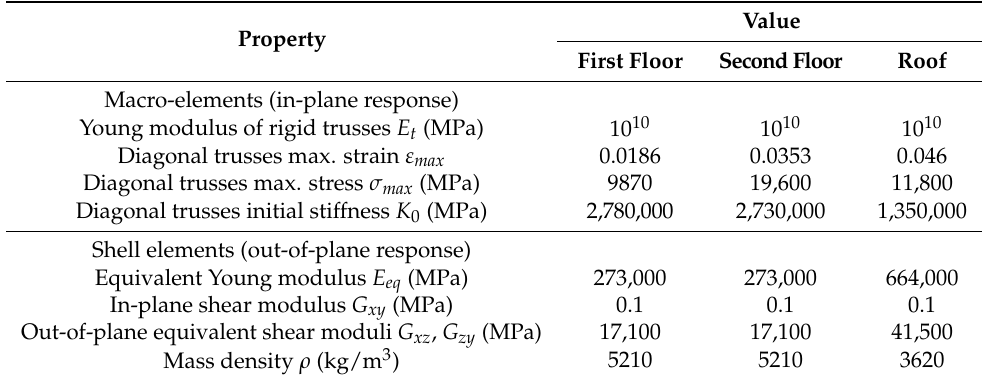
Table 11. Properties of the shell elements (thickness = 36 mm) and macro-elements representing the diaphragms retrofitted with plywood panels in configurations B3-PP. Value Property First Floor Second Floor Roof Macro-elements (in-plane response) Young modulus of rigid trusses E t (MPa) 10 10 10 10 10 10 Diagonal trusses max. strain ε max 0.0186 0.0353 0.046 Diagonal trusses max. stress σ max (MPa) 9870 19,600 11,800 Diagonal trusses initial stiffness K 0 (MPa) 2,780,000 2,730,000 1,350,000 Shell elements (out-of-plane response) Equivalent Young modulus E eq (MPa) 273,000 273,000 664,000 In-plane shear modulus G xy (MPa) 0.1 0.1 0.1 Out-of-plane equivalent shear moduli G xz , G zy (MPa) 17,100 17,100 41,500 Mass density ρ (kg/m 3 ) 5210 5210